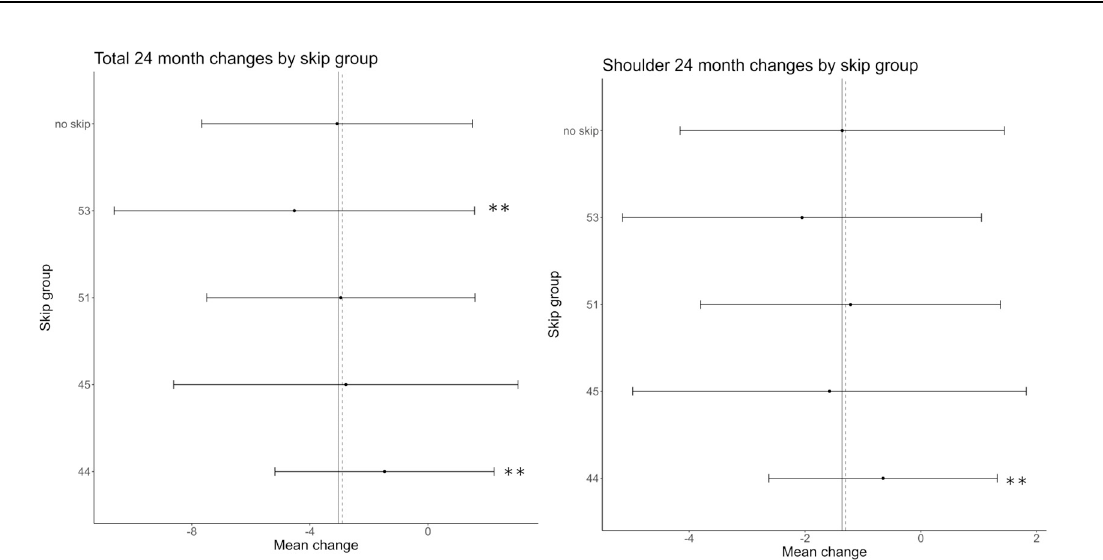
Figure 1. Details of mean changes and SD of the individual exon classes in relation to the mean changes in the whole DMD cohort (vertical dashed line) and in the groups including all deletions (vertical solid line). ** = signi fi cant di ff erence from the mean changes of all deletions.